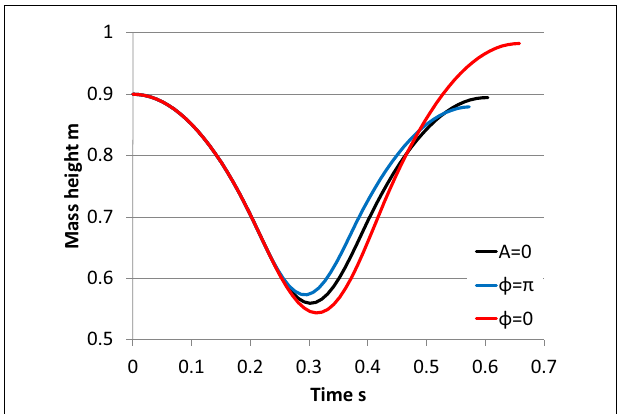
FIGURE 4 | Foot placement control . The position of the foot with respect to the body when landing has a great influence on the running speed. In steady running without changing the running speed, the SLIP model should land its foot at the mid-point of the distance that the SLIP model moves while standing (A) . When the SLIP model accelerates, the SLIP model should land in front of the mid-point for utilizing forward-fall rotation (B) .